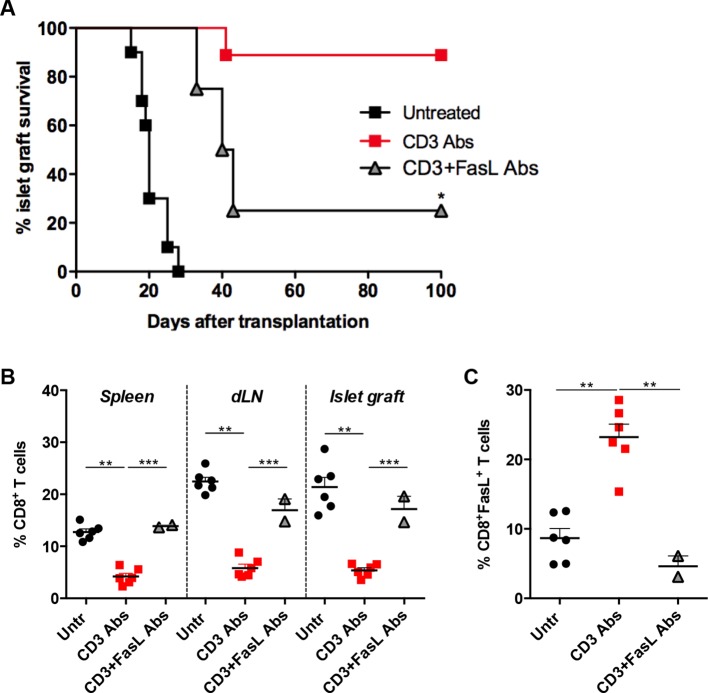
FasL blockade reversed CD3 antibody-induced transplant tolerance.(A) Graft survival of BALB/c islets was measured in C57BL/6 mice treated at day 7 with CD3 antibodies (50 μg, 5 days) alone (n = 10) or combined with neutralizing antibodies against FasLigand injected at the dose of 500 μg i.p. on day 6, 7 and 8 post-transplant (n = 4) (*p<0.02 between anti-CD3 and anti-CD3+anti-FasL Ab-treated mice). (B) Additional untreated (n = 6), CD3 Ab (n = 6) or CD3+FasL Ab (n = 2)-treated mice were sacrificed on day +14 post-transplant and proportion of CD8+ T cells was analyzed in the spleen, renal draining lymph nodes (dLN) and the islet allografts (**p<0.003, ***p<0.0006). (C) Expression of FasL by graft infiltrating CD8+ T cells isolated on day +14 from untreated (n = 6), CD3 Abs (n = 6) or CD3+FasL Abs (n = 2)-treated recipients (**p<0.002).